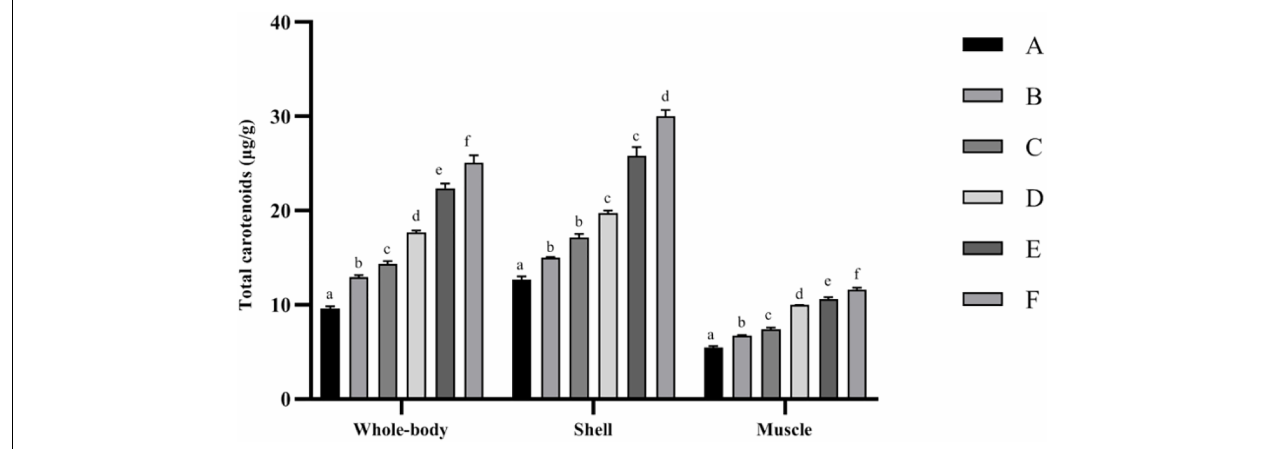
FIGURE 1 | Total carotenoid contents of Penaeus monodon fed with different astaxanthin levels for 56 days. Data are expressed as mean ± SEM from triplicate groups. Different letters indicate significant ( p < 0.05) differences among various bars. S.E.M., standard error of